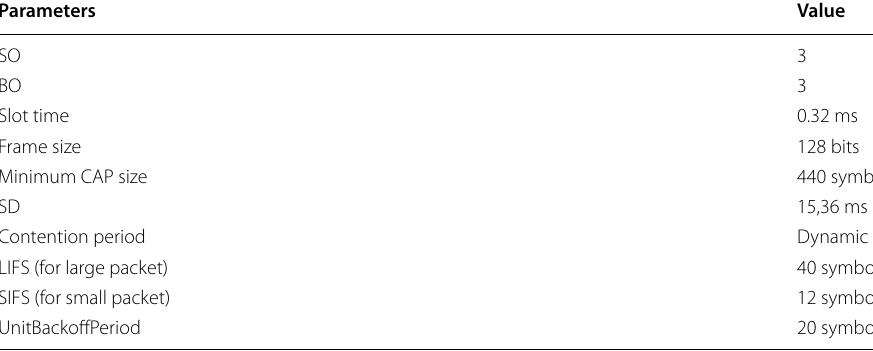
Table 1 Super-frame parameters Parameters Value SO 3 BO Slot time Frame